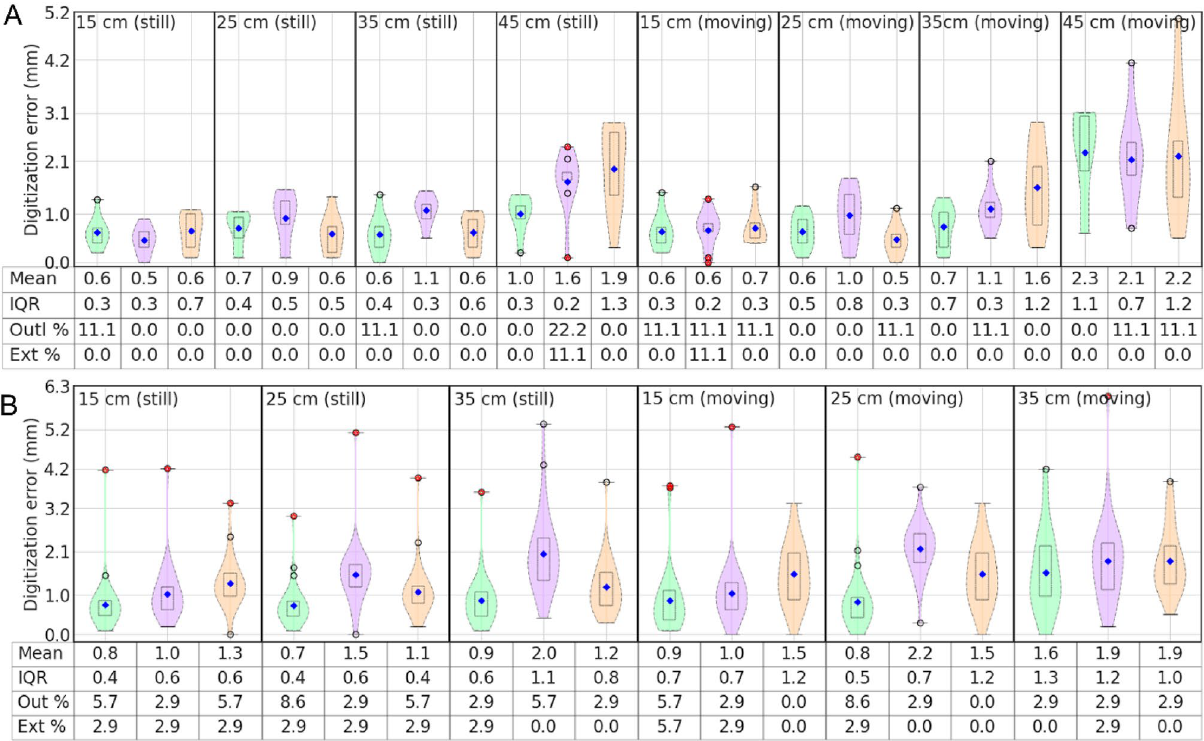
Figure 6. Digitization error for the ( A ) 3D test-frame and ( B ) Styrofoam head model with 35 marked “scalp” points, when models were kept either still or moving during digitization and when the transmitter–stylus distance was varied from 15 to 45 cm.